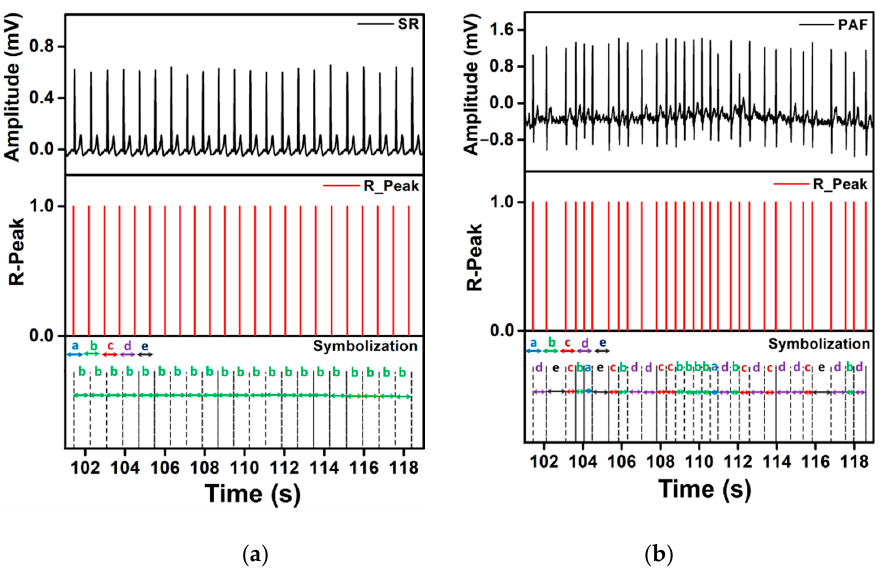
Figure 5. Representative SR ( a ), and PAF ( b ) segments with their corresponding RR interval and discretized symbolic sequences.